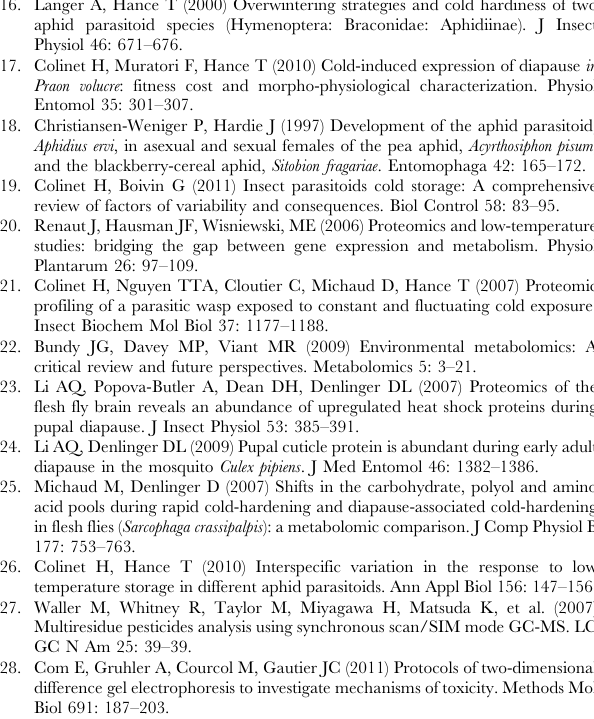
Table S1 List of the identified proteins. The following information is displayed in the table: Spot Numb (Decyder master gel spot number); Cmpd. (DataAnalysis compound number), m/z meas. (m/z measured), Mr calc. (Mr calculated), z (charge), D m/z (m/z deviation) [ppm], RMS90 (root mean square) [ppm], Rt (retention time) [min], scores (individual mascot ion score), Peptide sequence (sequence of the identified peptide), Accession (NCBI accession number), Protein (Protein Name).